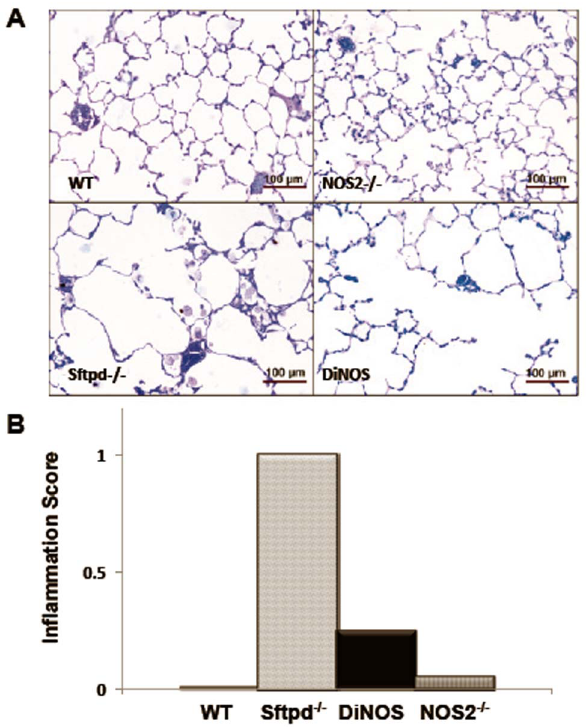
Figure 2. Lung histology reveals parenchymal inflammation in Sftpd 2 / 2 mice and reduced enlargement of distal airspaces in DiNOS. (A) Representative micrographs of lung sections from WT (upper left), NOS2 2 / 2 (upper right), Sftpd 2 / 2 (lower left) and DiNOS (lower right) mice (toluidine blue staining). Normal lung architecture can be seen in WT and NOS2 2 / 2 mice. In Sftpd 2 / 2 the distal airspaces are enlarged and filled with foamy appearing alveolar macrophages. Enlargement of distal airspaces appears to be less pronounced in DiNOS compared to Sftpd 2 / 2 mice. (B) Histological scoring of lung inflamma- tion. Median inflammation scores were determined by blinded evaluation of stained sections from each genotype group as described in Online Supplement Methods. Data shown are Median, n=7 animals per genotype.